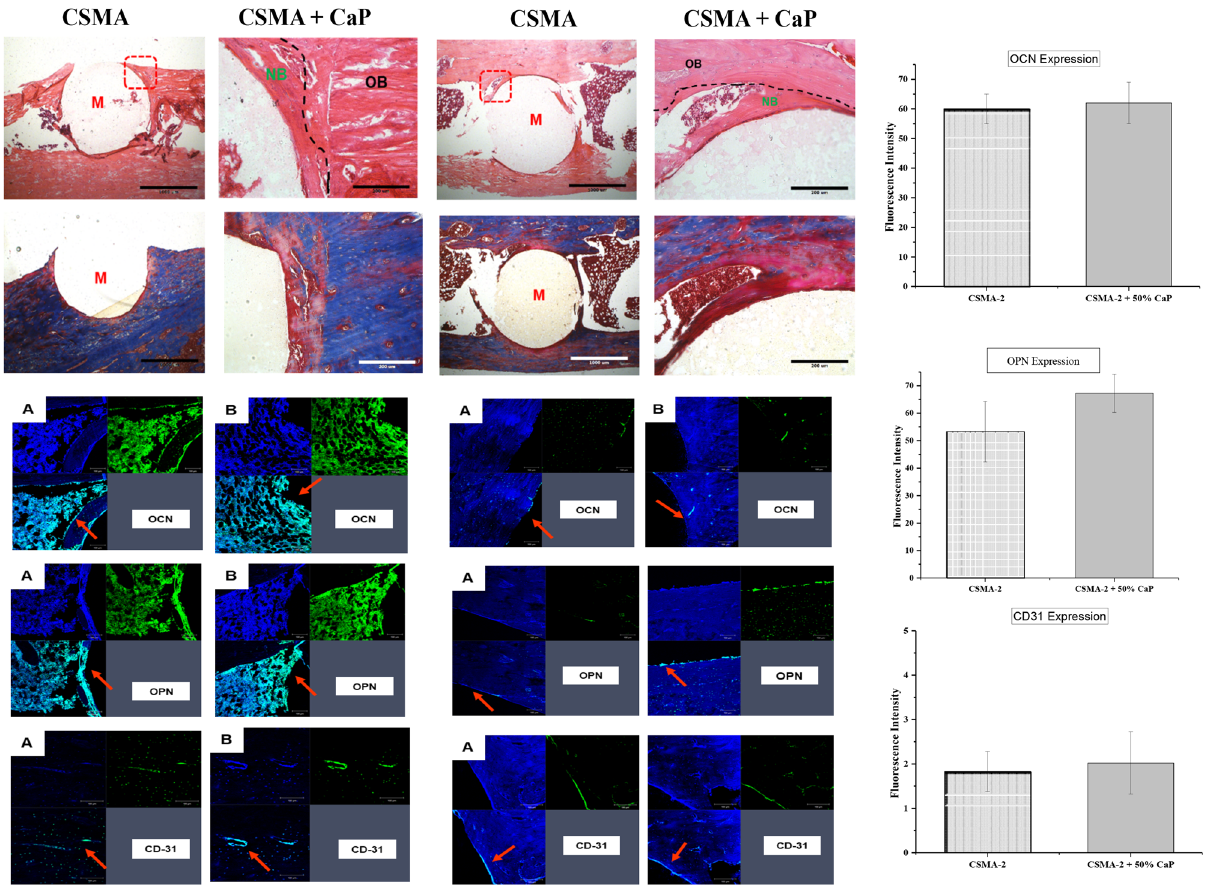
Figure 11. Histological evaluation and illustration of H&E and Masson’s Trichome stains 4- and 8-weeks post- implantation of CMSA and CSMA + CaP: a general overview of the sectioned samples can be observed where